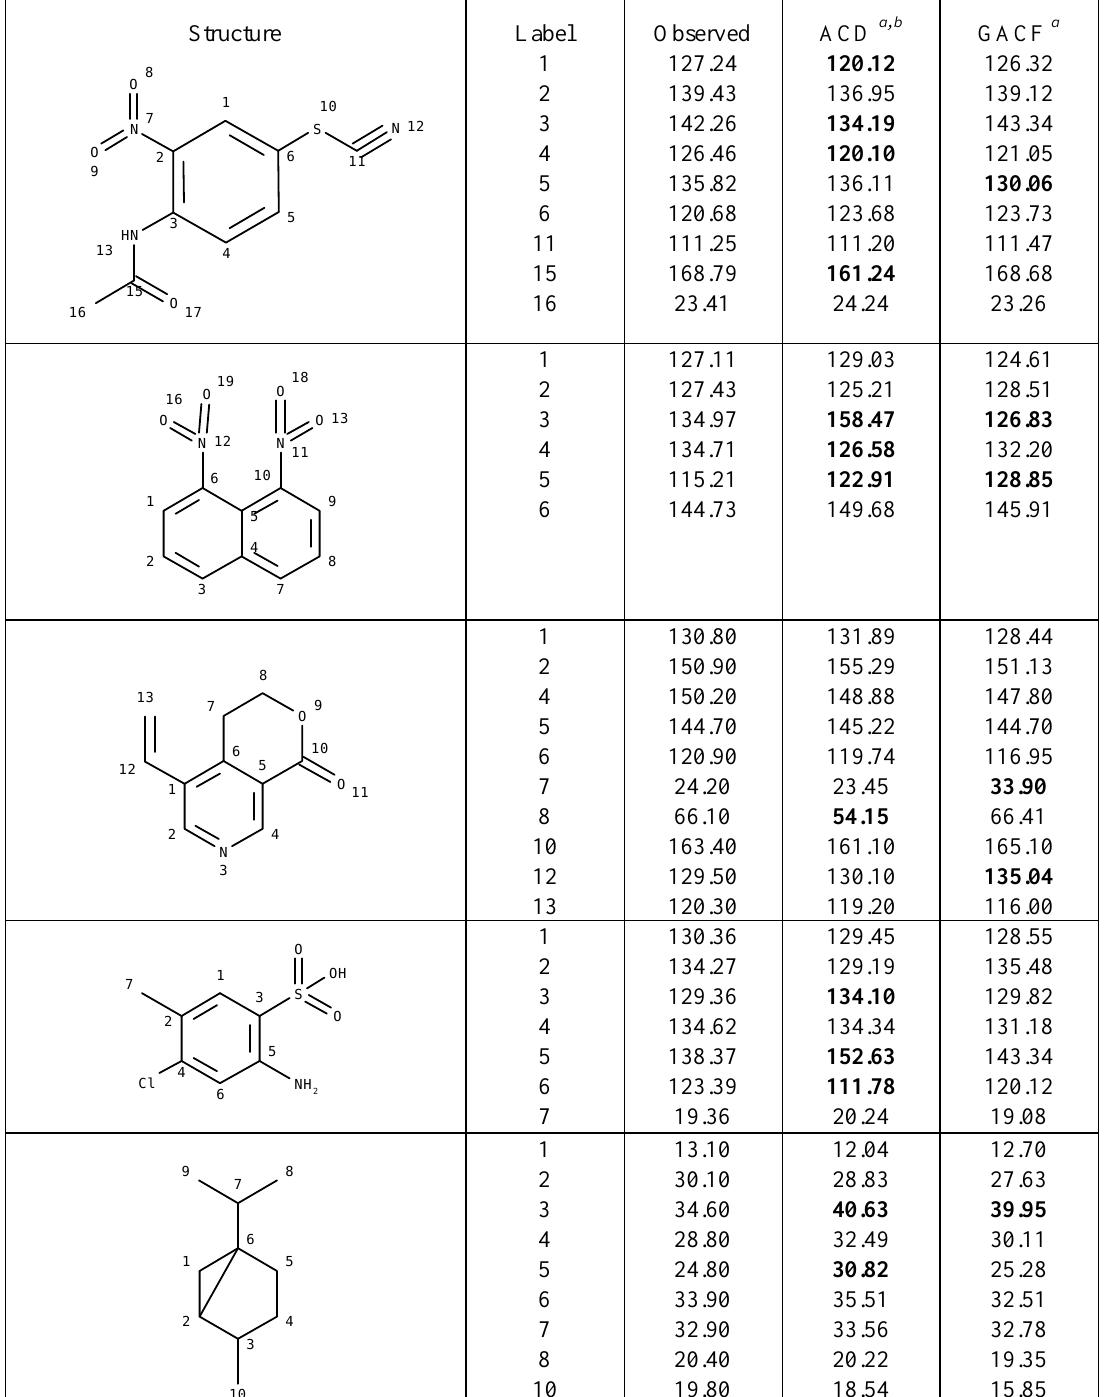
Table 3. Comparisons of observed chemical shift values, ACD/CNMR predictions and GACF